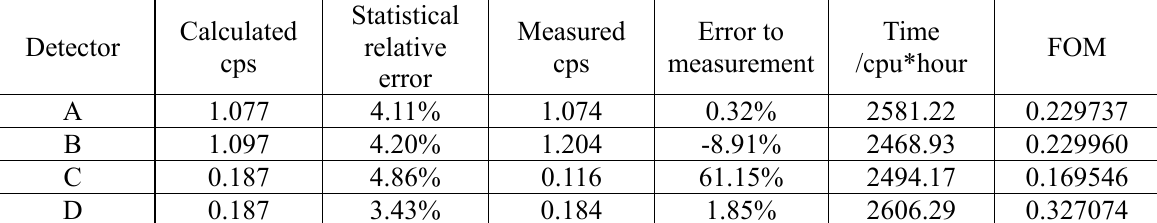
Table I. : Results calculated by NECP-MCX with the hybrid method